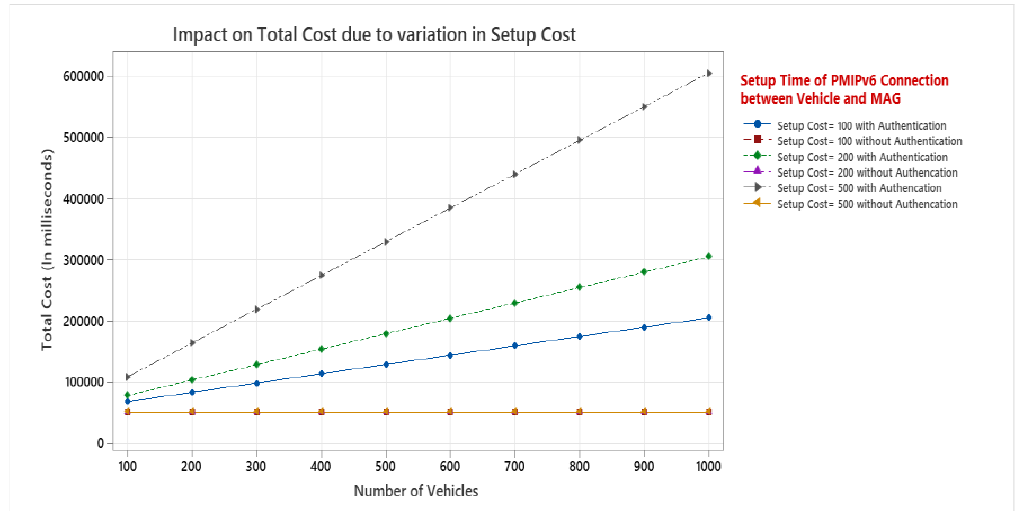
Figure 9. Impact on Total Cost due to variation in Setup Cost.